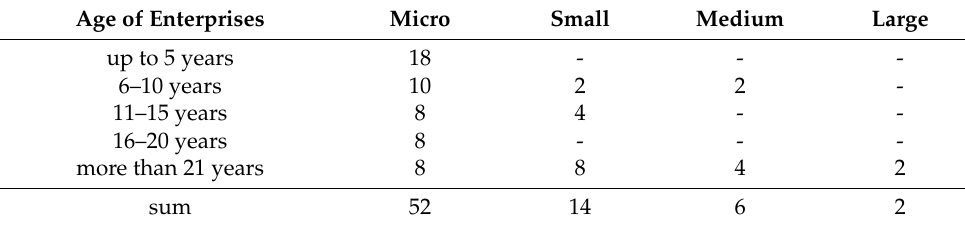
Table 1. Classification of enterprises by age of enterprises. Age of